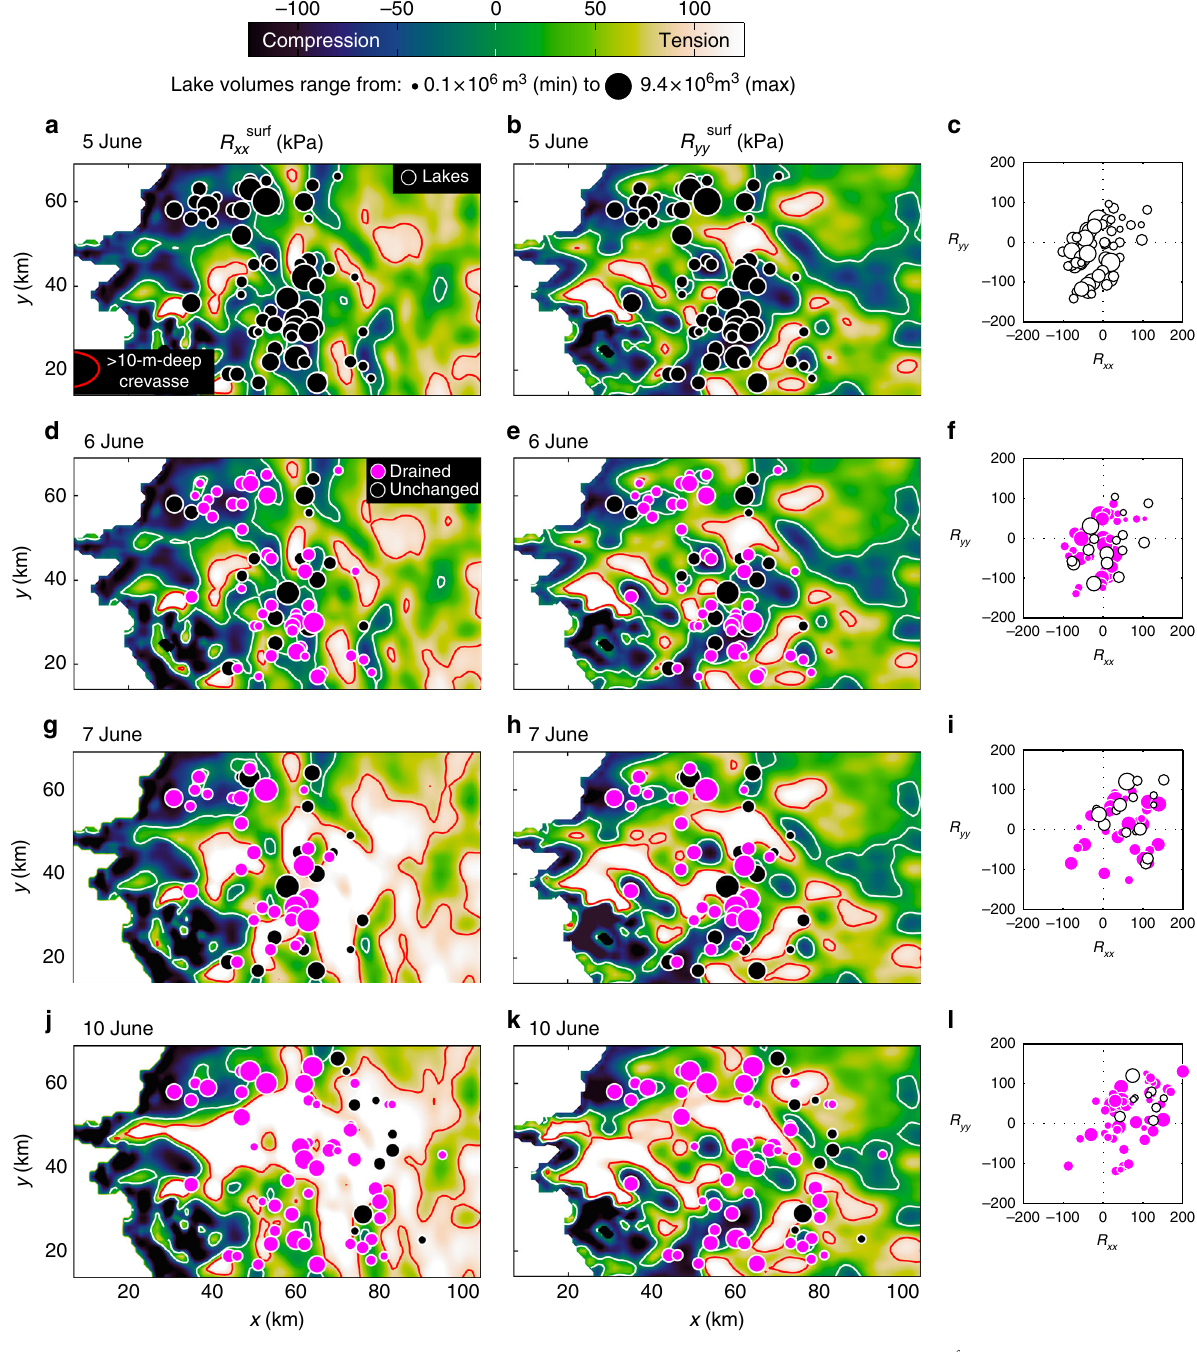
Fig. 3 Stress-induced crevasse opening during cascading lake drainage event. a Resistive stress in the x direction ( R surf xx , kPa) on 5 June. Solid black dots show location and size of 59 supraglacial lakes on the ice sheet that day. White line is the R surf xx ¼ 0 contour. Red line de fi nes regions where the tensile stresses extend crevasses to a depth of 10 m or more. b Same as a but showing resistive stress in the y direction ( R surf yy , kPa). c R surf xx and R surf yy (kPa) at sites where lakes formed. Open black circles are scaled with stored volume of water in each lake. d Distribution of R surf xx (kPa) subsequent to the drainage of 43 lakes (magenta dots) on 6 June. Black dots indicate location and size of lakes that had formed but did not drain that day. e Same as d but showing R surf yy (kPa). f R surf xx and R surf yy (kPa) for lakes that drained (magenta dots) and remained intact (open black circles) on 6 June. g Distribution of R surf xx (kPa) after 30 additional lakes drained on 7 June (magenta dots). Black dots show 16 lakes that did not drain that day. h Same as g but showing R surf yy (kPa). i Same as f but for lakes observed on 7 June. j Distribution of R surf xx (kPa) after 51 additional lake drainage events by 10 June. Clouds obscured lake observation on 8 – 9 June. k Same as j but showing R surf yy (kPa). l Same as i but for lakes observed on 10 June. Note how ice fl ow at lake sites become increasingly extensional as more lakes drain, and how the regions with >10-m-deep crevasses expand as the cascading lake drainage event